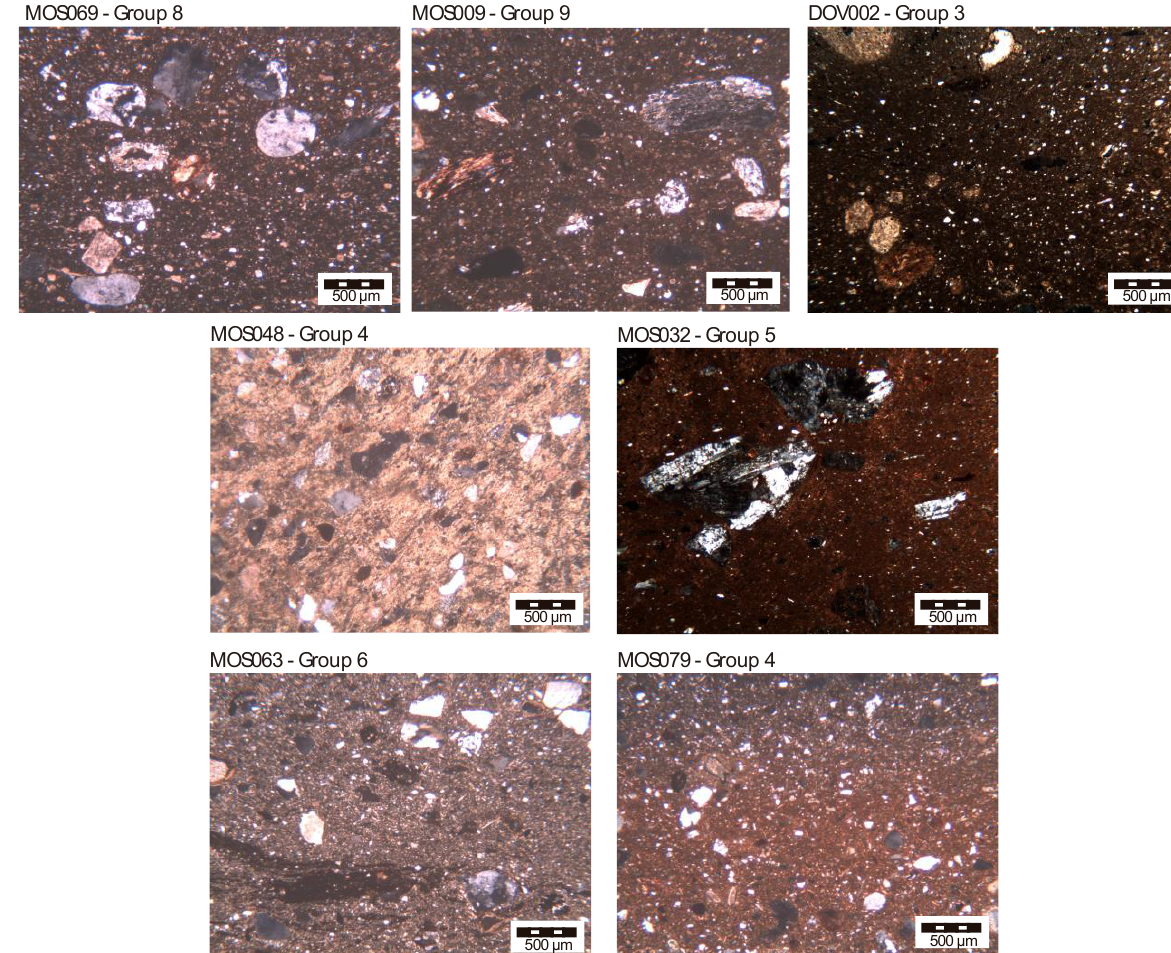
Figure 7. Photomicrographs of main petrographic fabrics (all under crossed polars, XP). Group 8: showing well-rounded quartz and micrite. MOS069 (PXRD fabric CGGUA-I) in XP (x25); Group 9: showing well-rounded inclusions of low-grade metamorphic rocks and garnets. MOS009 (PXRD fabric CGTOS-II) in XP (x25); Group 3: showing micritic calcite, small quartz, and muscovite mica. DOV002 in XP (x25) (see [22]); Group 4: showing well-sorted angular quartz, micrite, and opaques disaggregated components of sandstone. MOS048 (PXRD fabric CG21-I) in XP (x25); Group 5: showing basic igneous rock fragments. MOS032 (PXRD fabric CG10-II) in XP (x25); Group 6: showing characteristic dark textural concentration features. MOS063 (PXRD fabric CG17-I) in XP (x25). Group 4: MOS079 (PXRD fabric CG19-I) in XP (x25). Red firing member of the petrographic fabric with quartz, micrite, and white